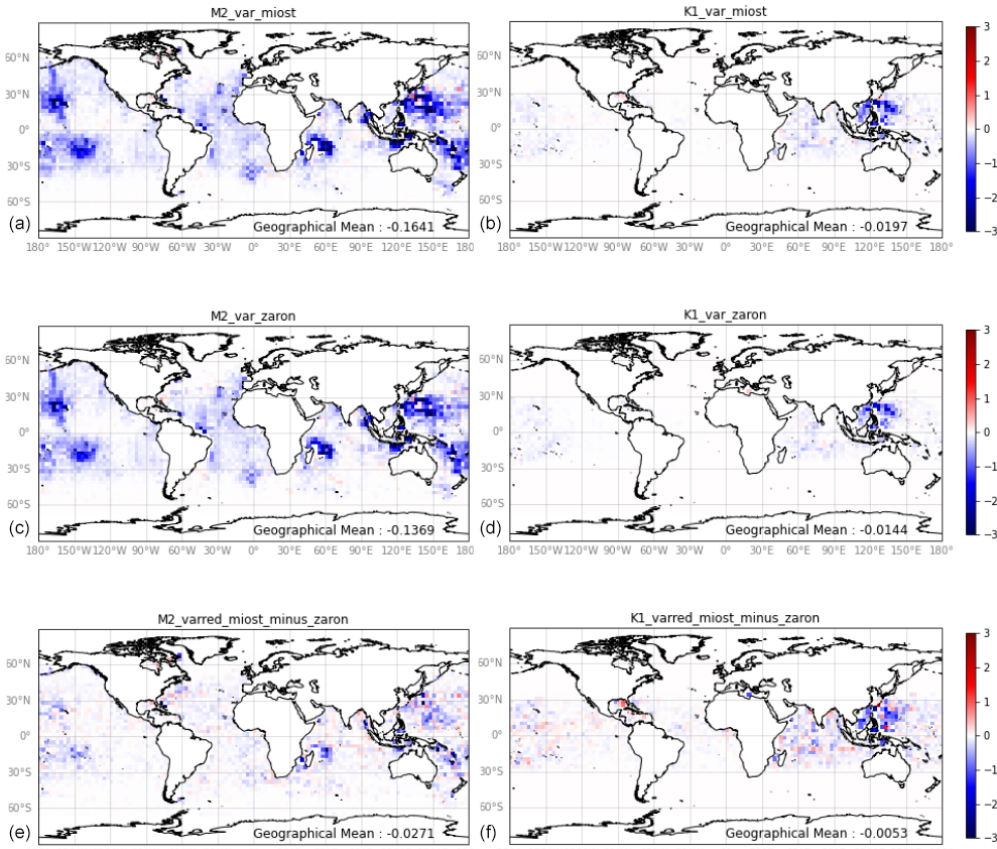
Figure 10. Difference of sea level anomaly variance (cm 2 ) between along-track data of all satellites before and after applying the internal tide prediction, averaged over the independent period September 2017–December 2019. (a, b) With simultaneous MIOST reconstruction for the M2 component (a, c, e) and for the K1 component (b, d, f) . (c, d) Same, with the Zaron, 2019 prediction model. (e, f) Difference between upper panels and middle panels.